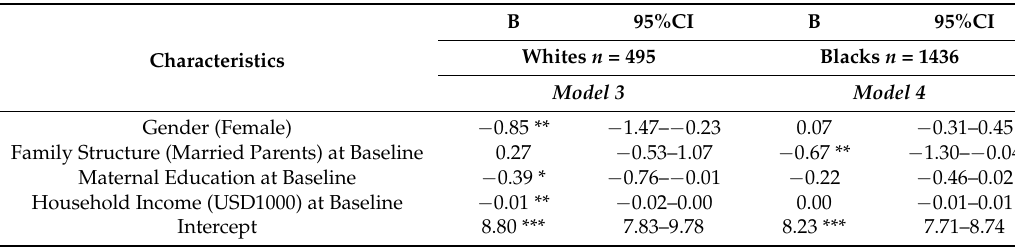
Table 4. Summary of linear regression models across